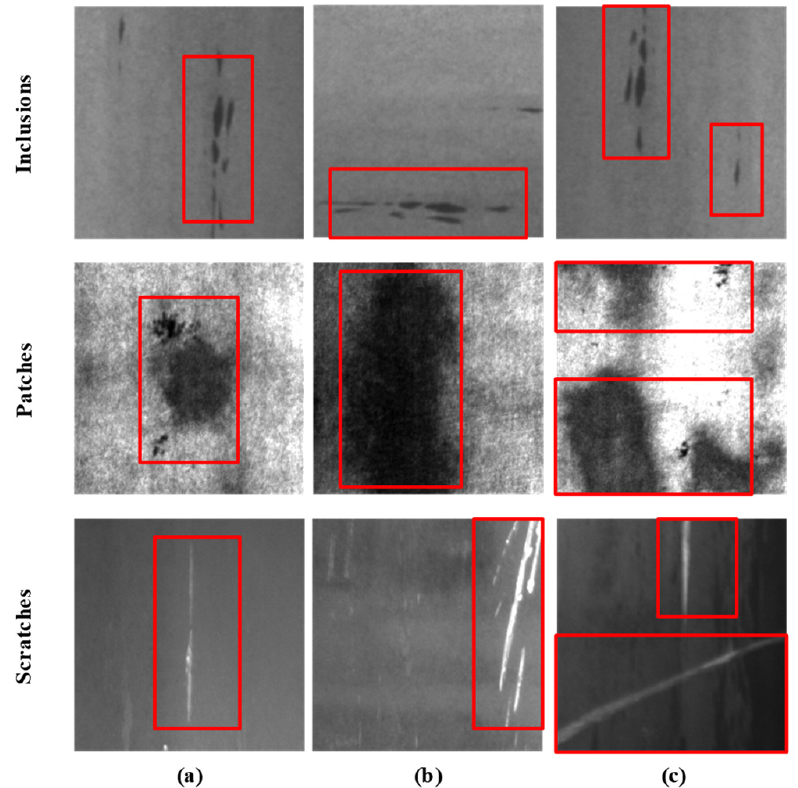
Figure 1. Three common strip surface defects, as follows: ( a – c ) represent ordinary, close to the defects of the edge, and the chaotic background defective image, respectively. The red box indicates the defective region.